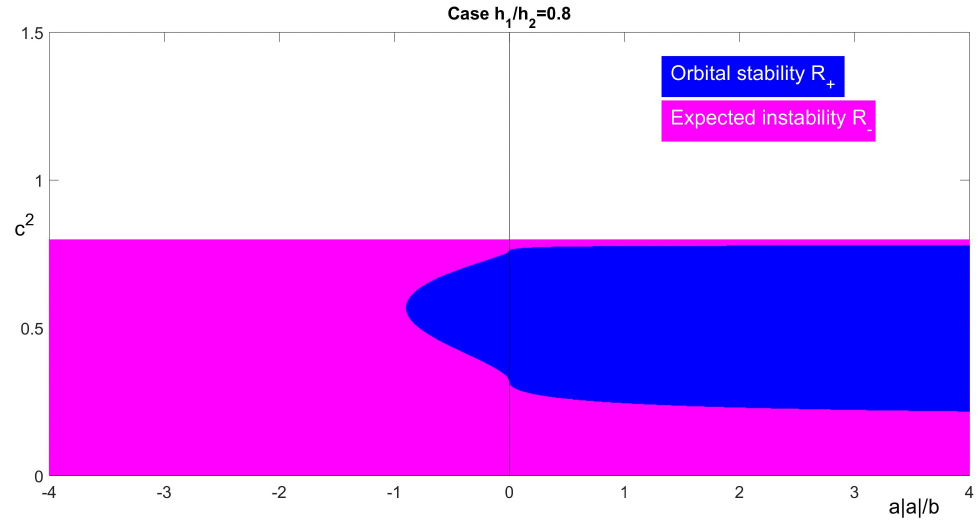
∈ ( − 4,4 ) and c 2 ∈ ( 0,0.8 ) : b